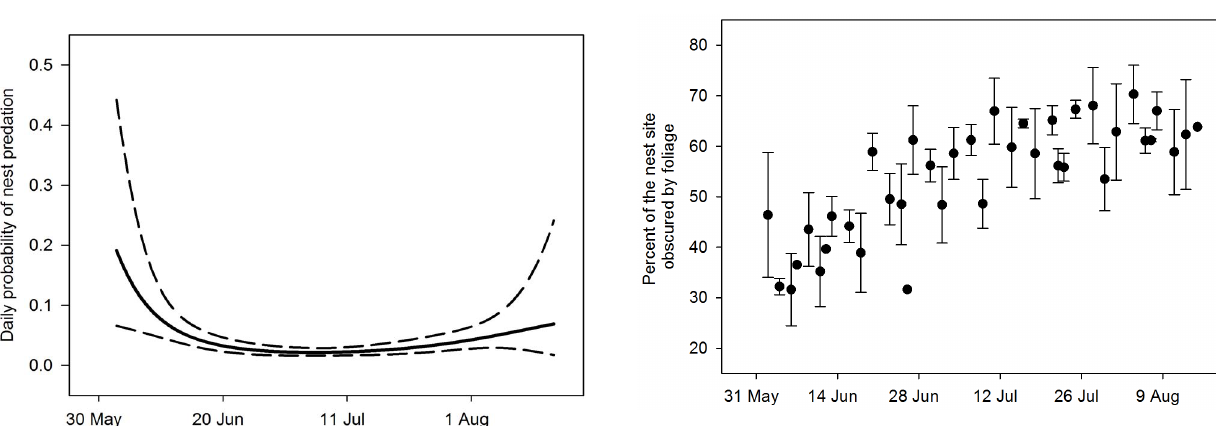
Figure 1. Seasonal variation in the daily probability of nest predation. Estimates of the daily probability of nest predation in Dusky Flycatchers (solid line) with 95% upper and lower confidence limits (dashed lines) generated from the best-supported model in step one of our modeling approach (Nest predation=Date + Date 2 ; Table 1).